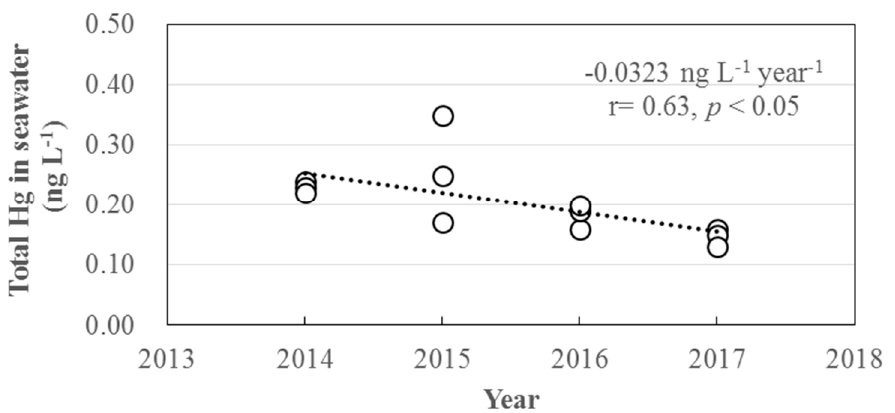
Figure 10. Long-term variations in the monthly mean GEM concentrations. The slope of the least-square regression represents its annual trend.